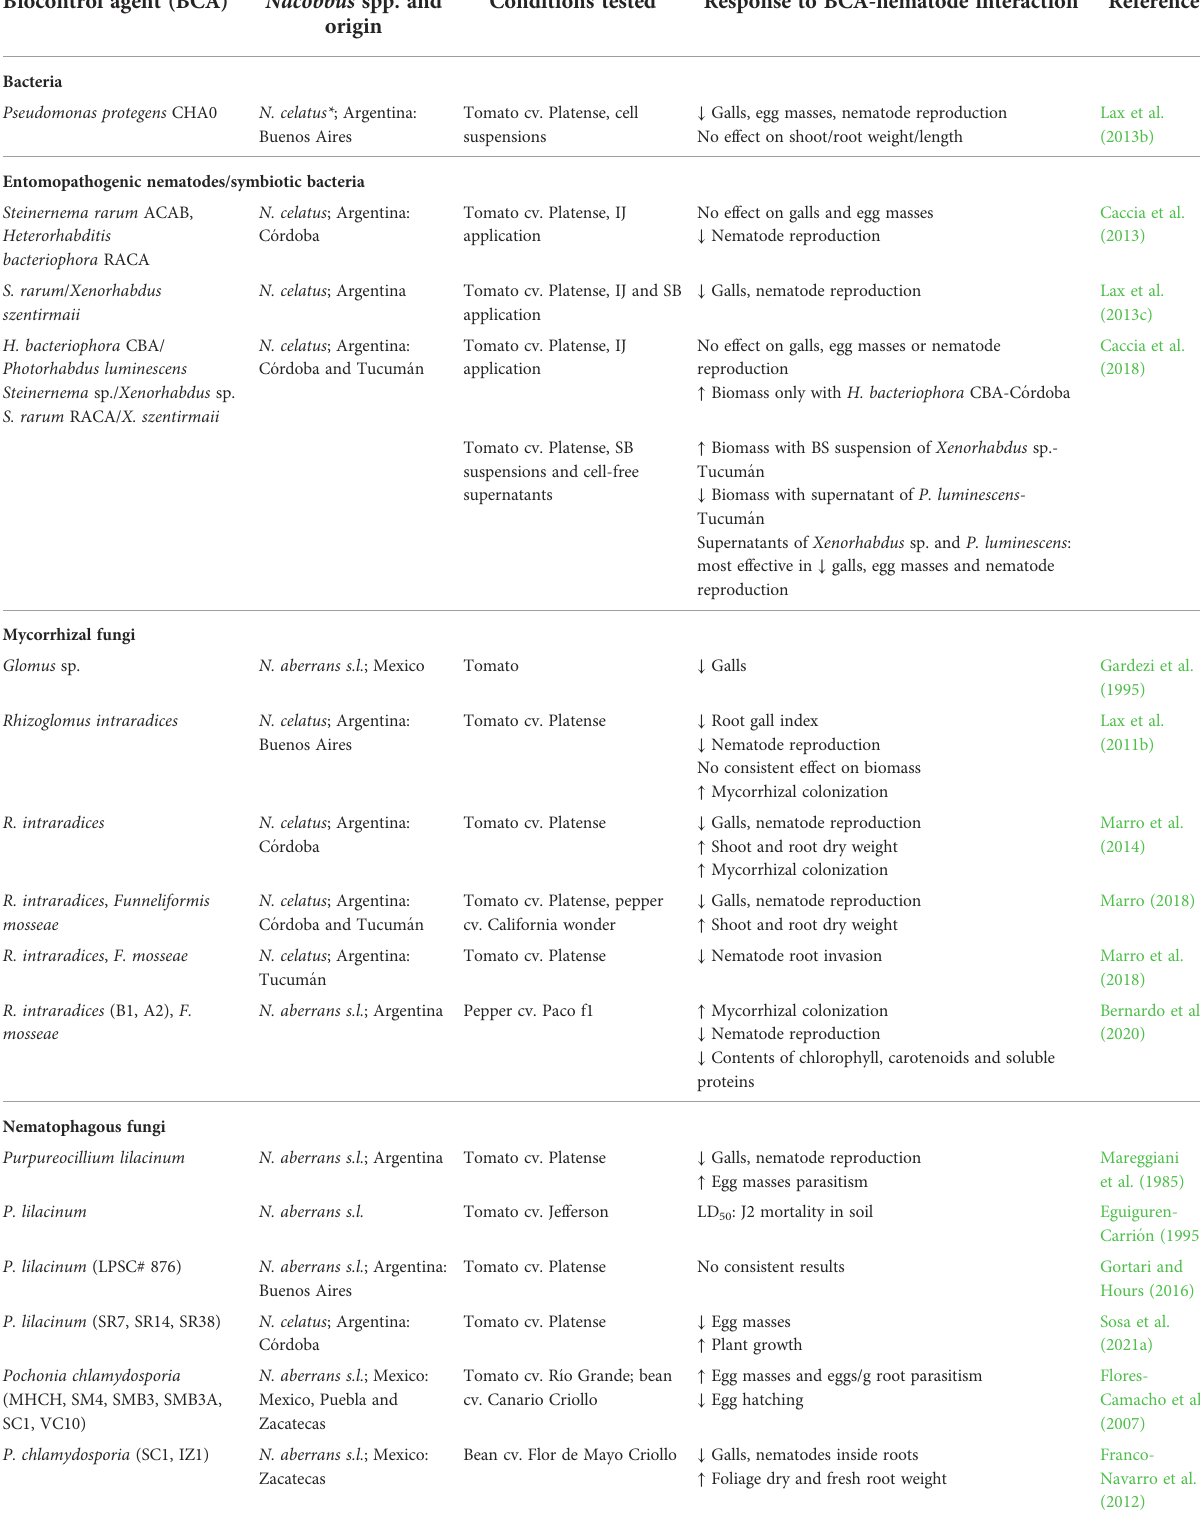
TABLE 2 Response of Nacobbus spp. to the interaction with different biological control agents in in vivo experiments. Biocontrol agent